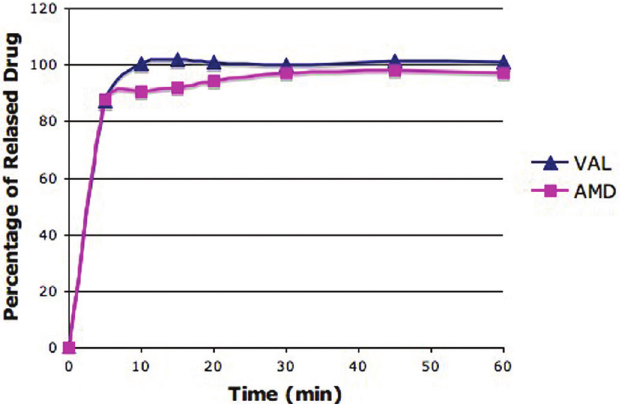
FIGURE 3 - In vitro dissolution profiles of AMD and